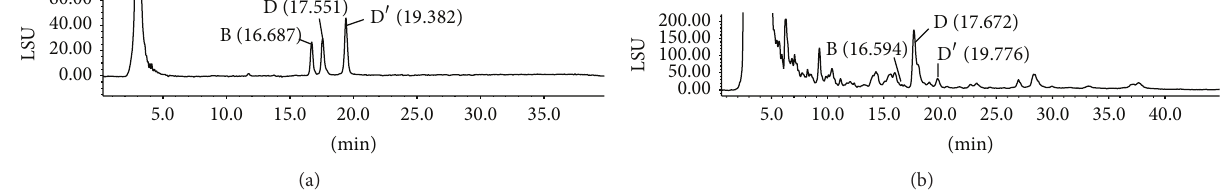
Figure 1: HPLC-ELSD chromatographs of standard mixture (a) and maidong extract